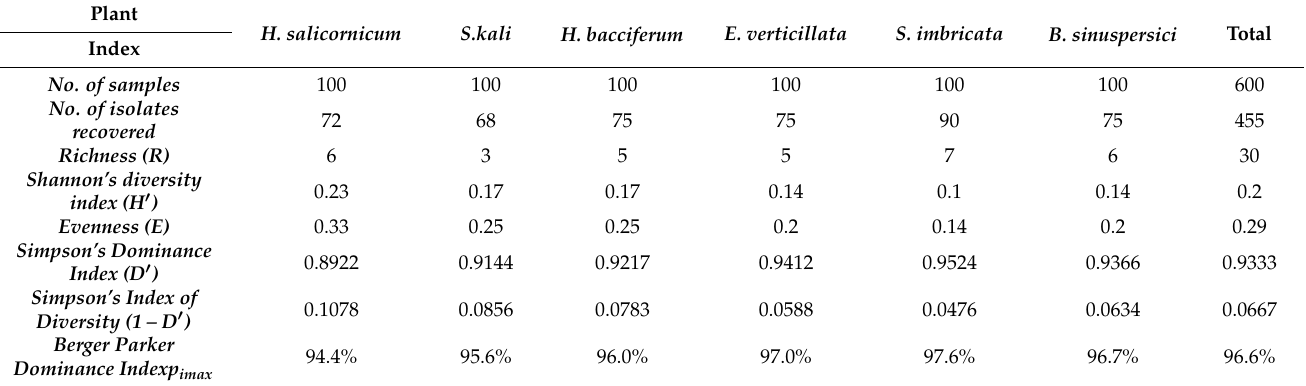
Table 5. Diversity indices of the 23 EF species identified from the six wild stress-tolerant plant